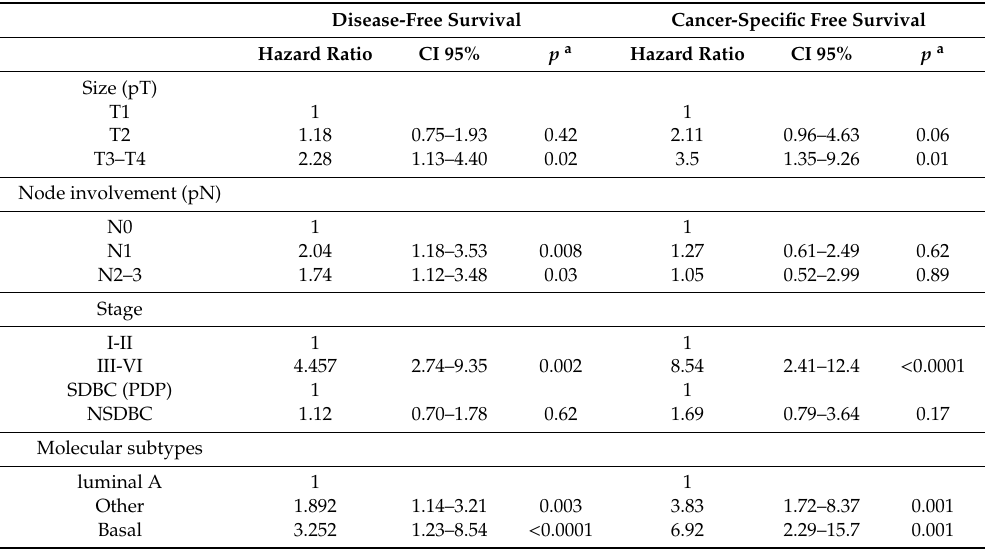
Table 6. Cox model for histopathologic and immunophenotypic features for disease-free survival and cancer-specific-free